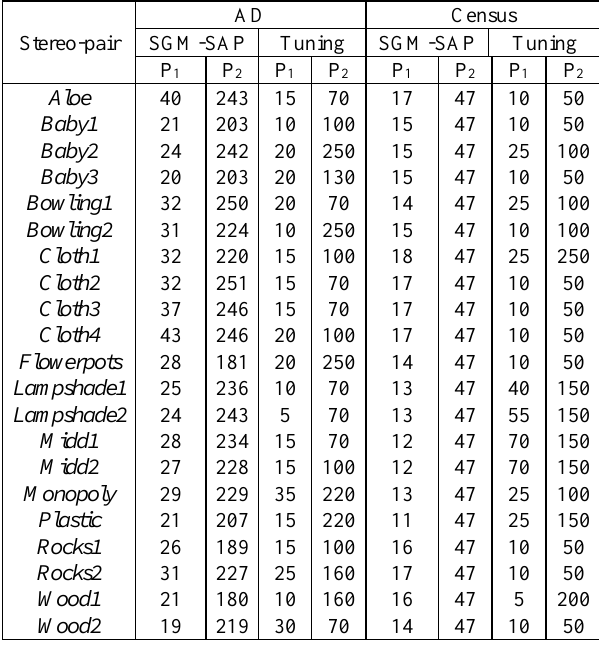
Table 2. Penalty values extracted from the tuning process and the values estimated by the suggested SGM-SAP method for each stereo-pair of Middlebury 2006 (using two cost metrics).